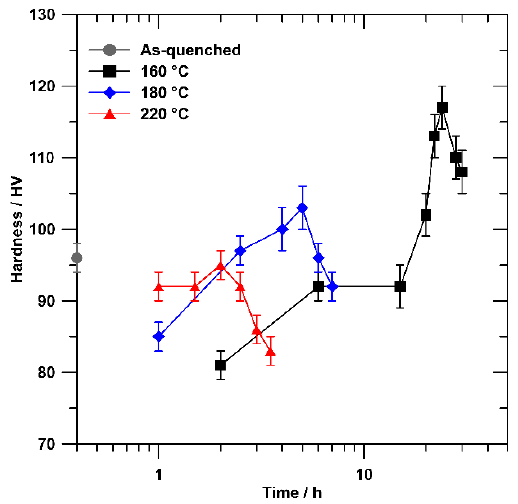
Figure 13. Age hardening curves of rheocast AlSi 9 Cu 3 (Fe) alloy solutioned at 470 ◦ C for 6 h. The as-quenched condition after the solution treatment is also indicated.